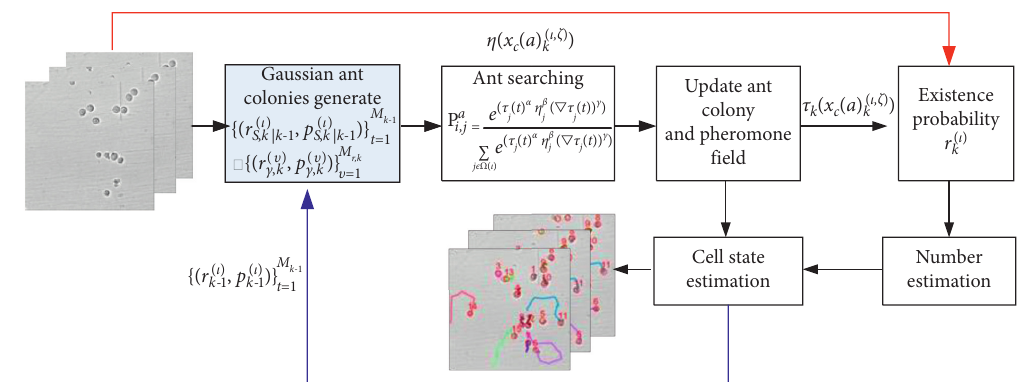
Figure 1: Framework of the proposed algorithm. Table 1: Basic